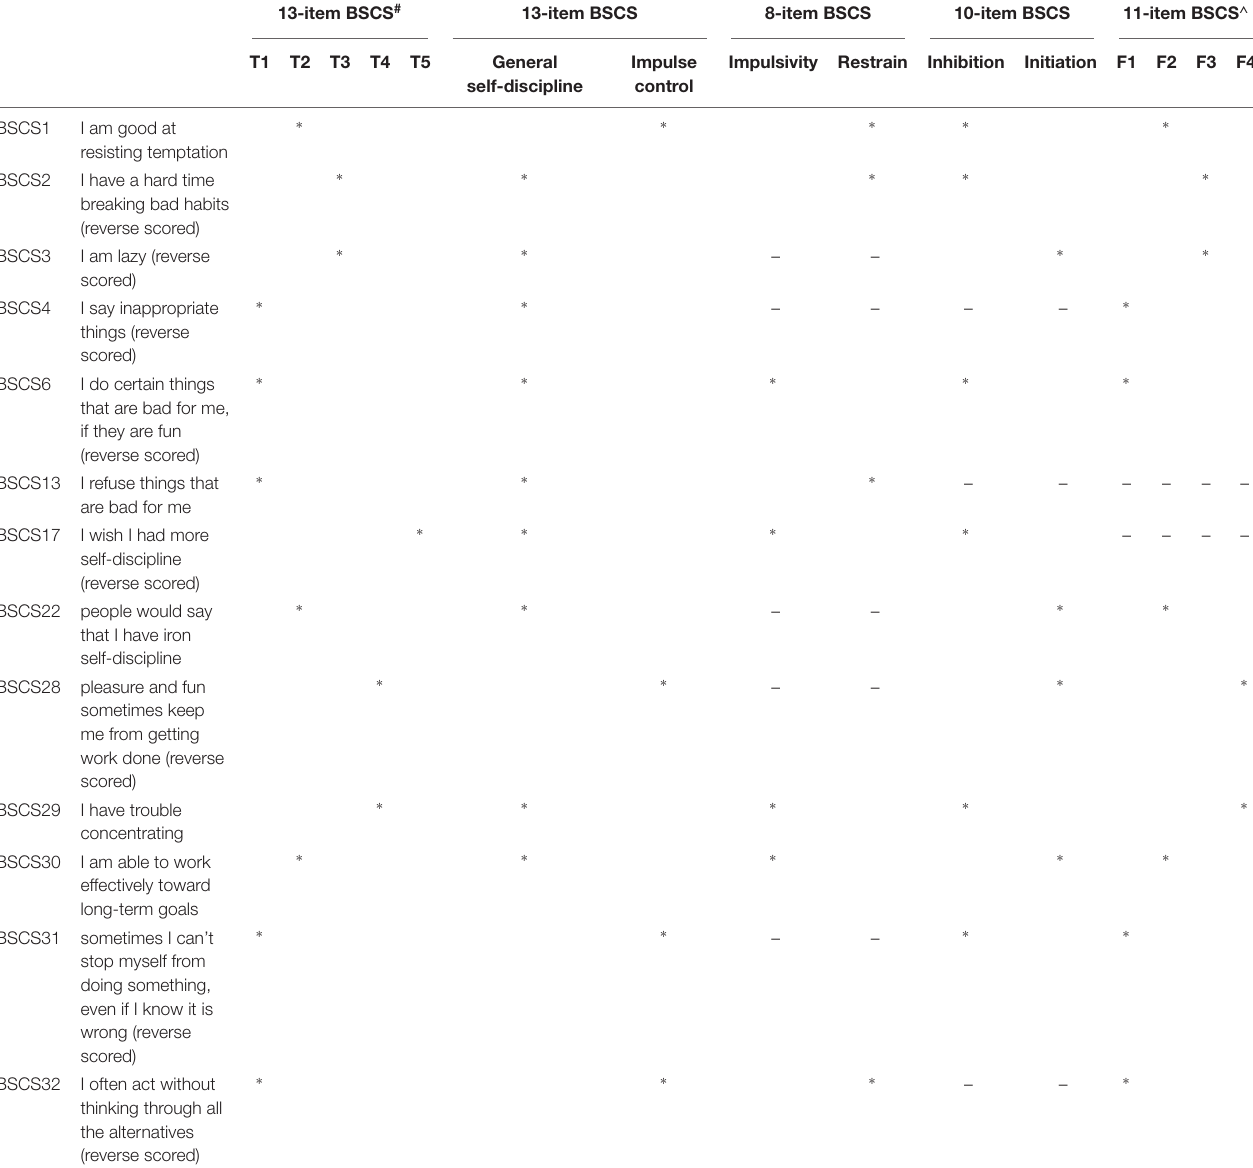
TABLE A1 | Conceptualization of the dimensionality of the Brief Self-Control